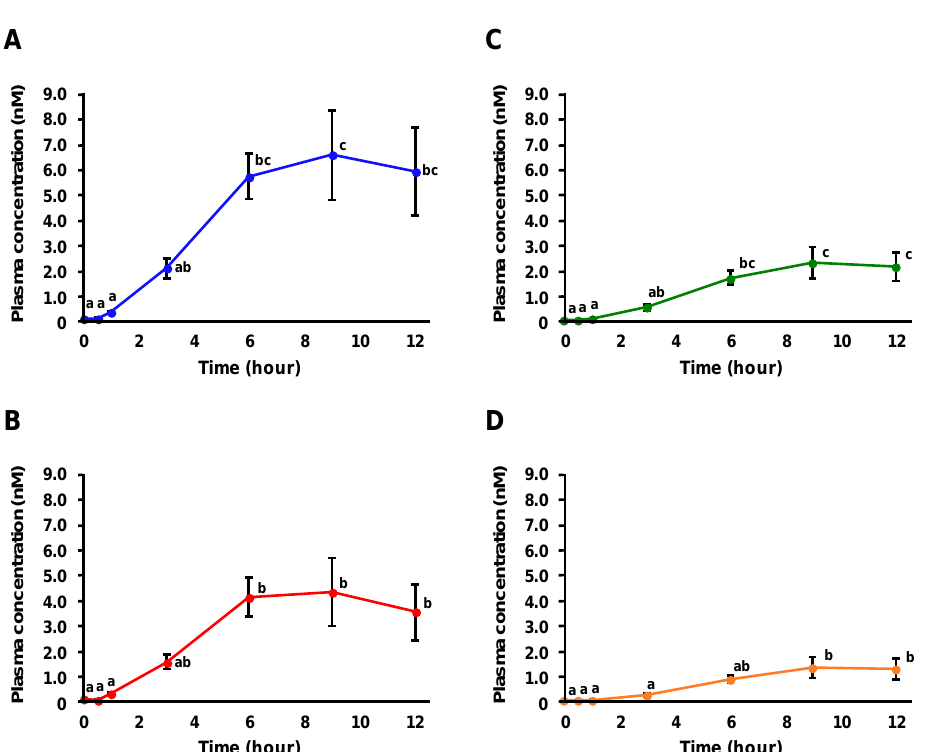
Figure 3. Time-dependent changes in plasma concentrations (nM) of each OZ molecular species (CA-FA ( A ), 24MCA-FA ( B ), Camp-FA ( C ), and Sito-FA ( D )) after RBOZ administration. Data are shown as means ± SE ( n = 6) and different letters represent significant difference at p < 0.05.